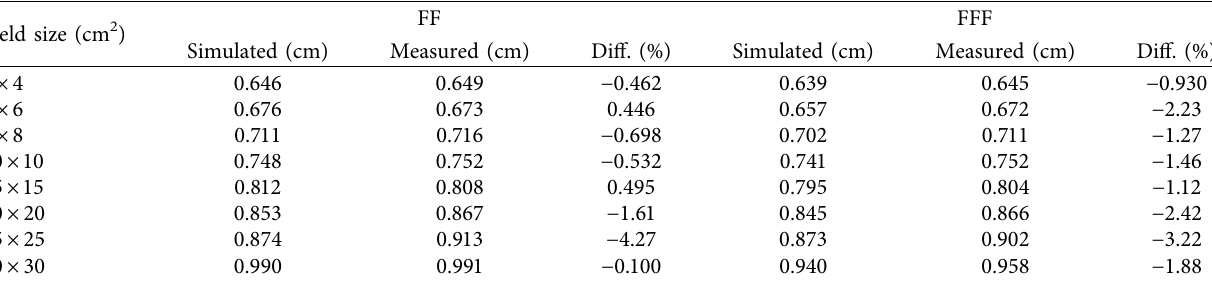
Table 5: The simulated and measured profiles of penumbras (cm) of FF and FFF beams for different fields at 10cm depth (The uncertainties of simulated penumbras in FF mode of 4 × 4, 6 × 6, 8 × 8, 10 × 10, 15 × 15, 20 × 20, 25 × 25, 30 × 30cm 2 fields were as follows: 0.4%, 0.8%,